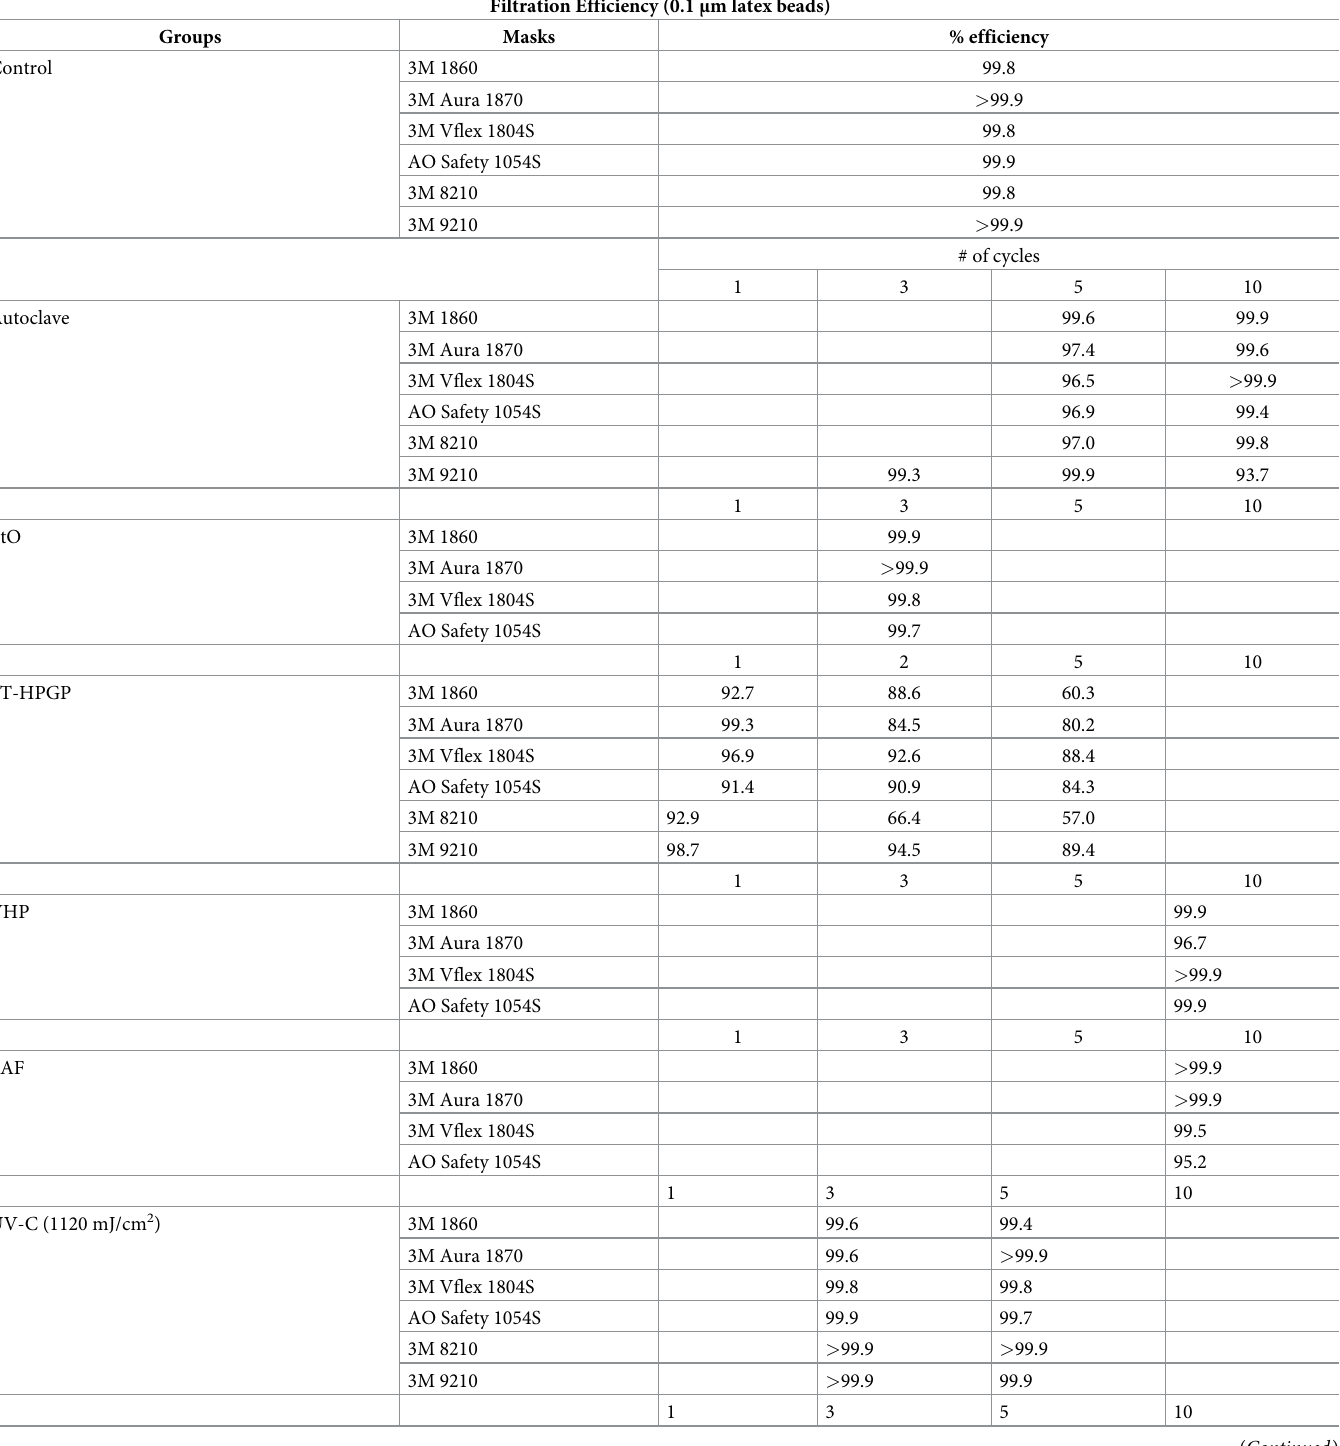
Table 3. Filtration efficiency testing results of N95 masks after repeat decontamination